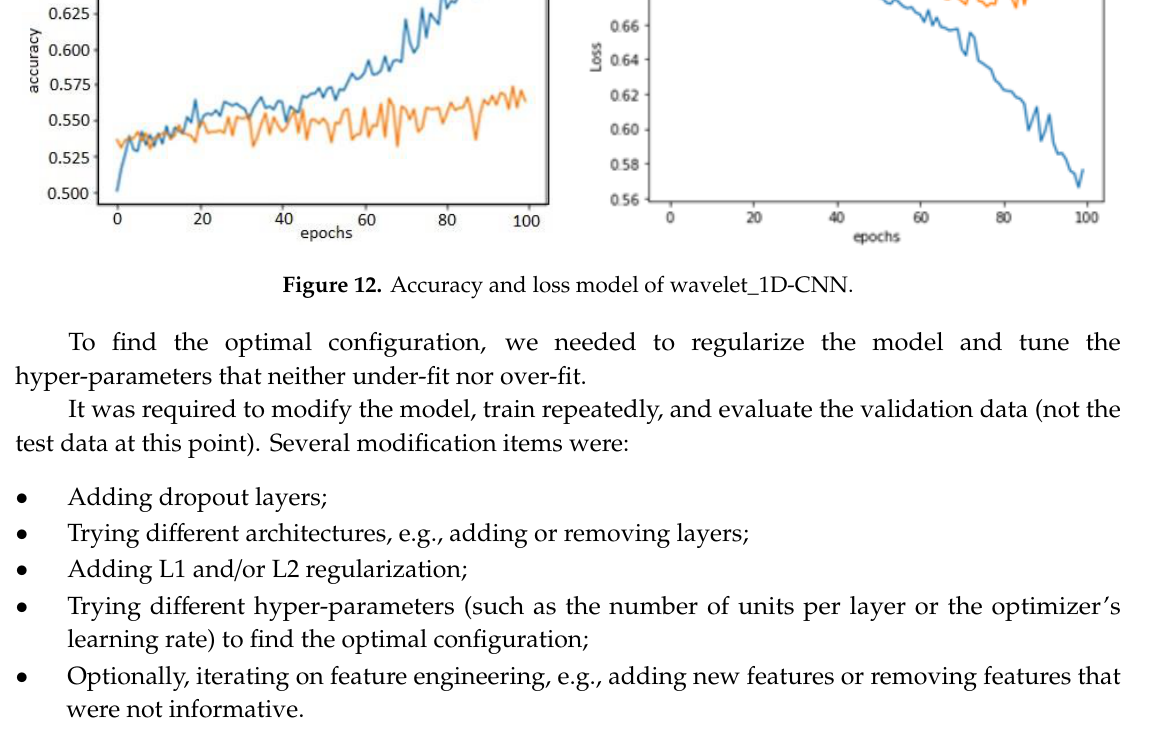
Figure 11. Accuracy and loss model of time-domain features 1D-CNN.